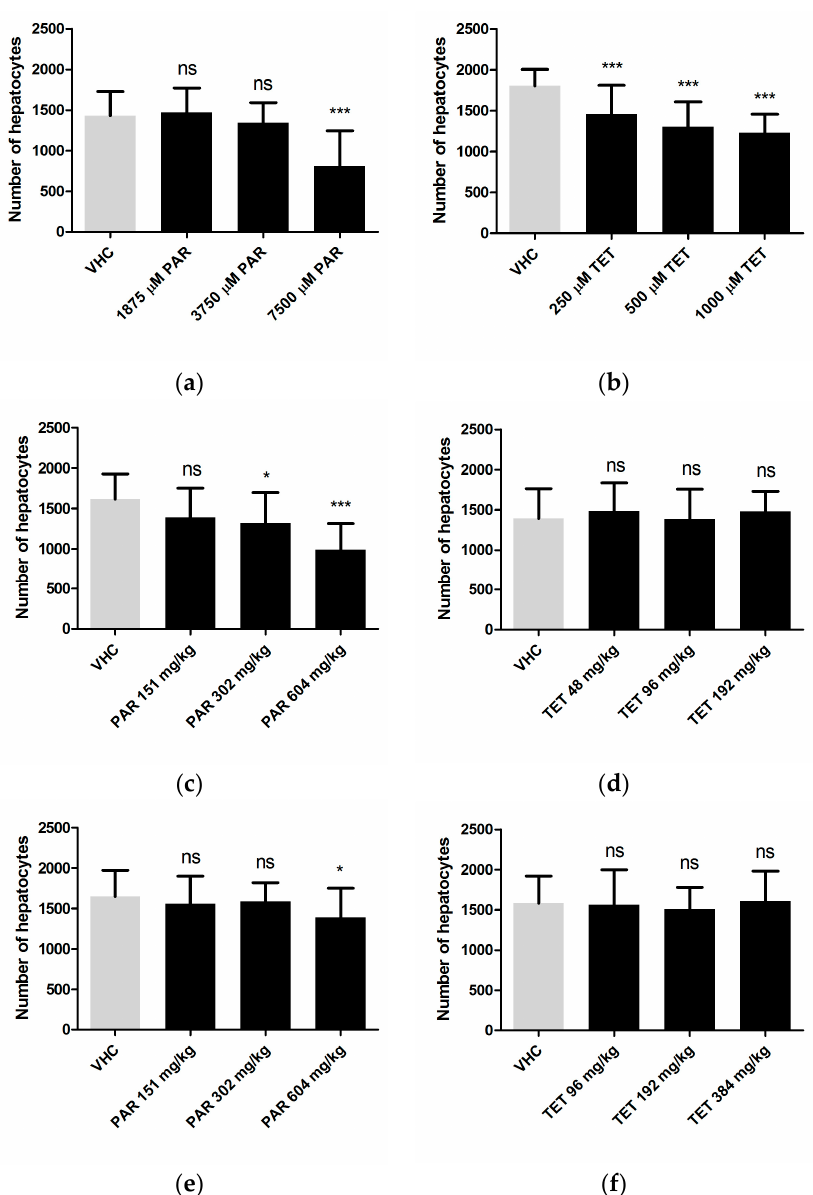
Figure 6. Hepatotoxicity assessed by quantification of DsRed-labeled hepatocytes using a CIC after immersion ( a , b ); yolk injection ( c , d ) and pericardial injection ( e , f ) of paracetamol ( a , c , e ) and tetracycline ( b , d , f ). Analysis was performed after three days of treatment (immersion) or three days after treatment (injection), at 6 dpf. A total of 10 and 12 larvae were used individually per condition for immersion and injections, respectively. The experiment was performed in triplicate and data were pooled. The data were analyzed using one-way ANOVA. ns: no statistically significant difference; *: p < 0.05; ***: p < 0.001; VHC: vehicle control; PAR: paracetamol; TET: tetracycline. Means ± SD of the number of hepatocytes per larva are shown.